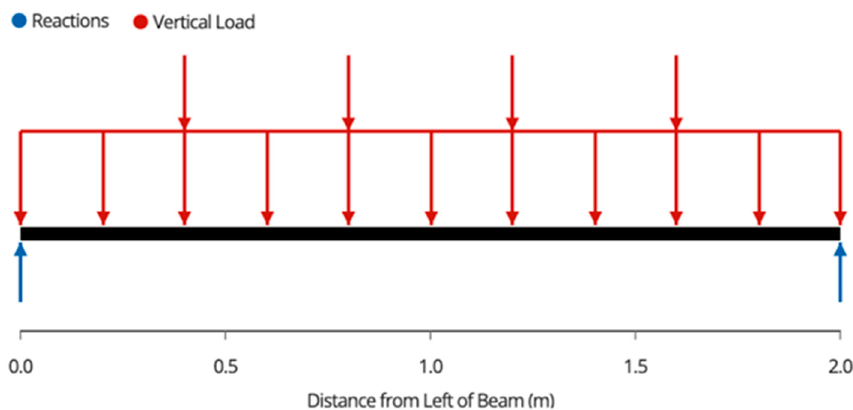
Figure A1. Free body diagram of joists. Note that the two outside joists will have half the tributary area of the inside joists and thus will carry approximately half of the load. Each joist is supported a beam on each end. The reaction and thus the load that each joist transfers to each beam is calculated using Equation (A3),